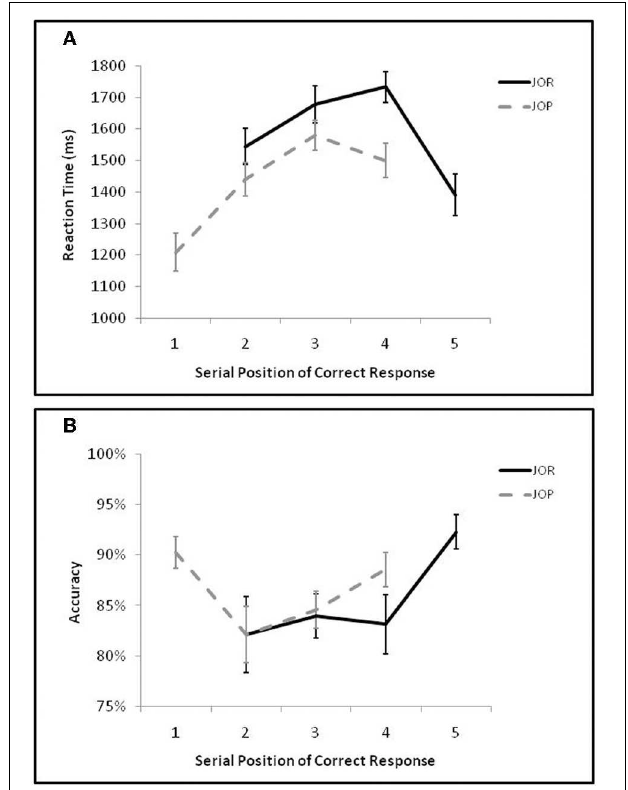
FIGURE 2 | (A) Average reaction time on correct trials as a function of the serial position of the correct item in the JOR and JOP tasks. (B) Average accuracy as a function of the serial position of the correct item in the JOR and JOP